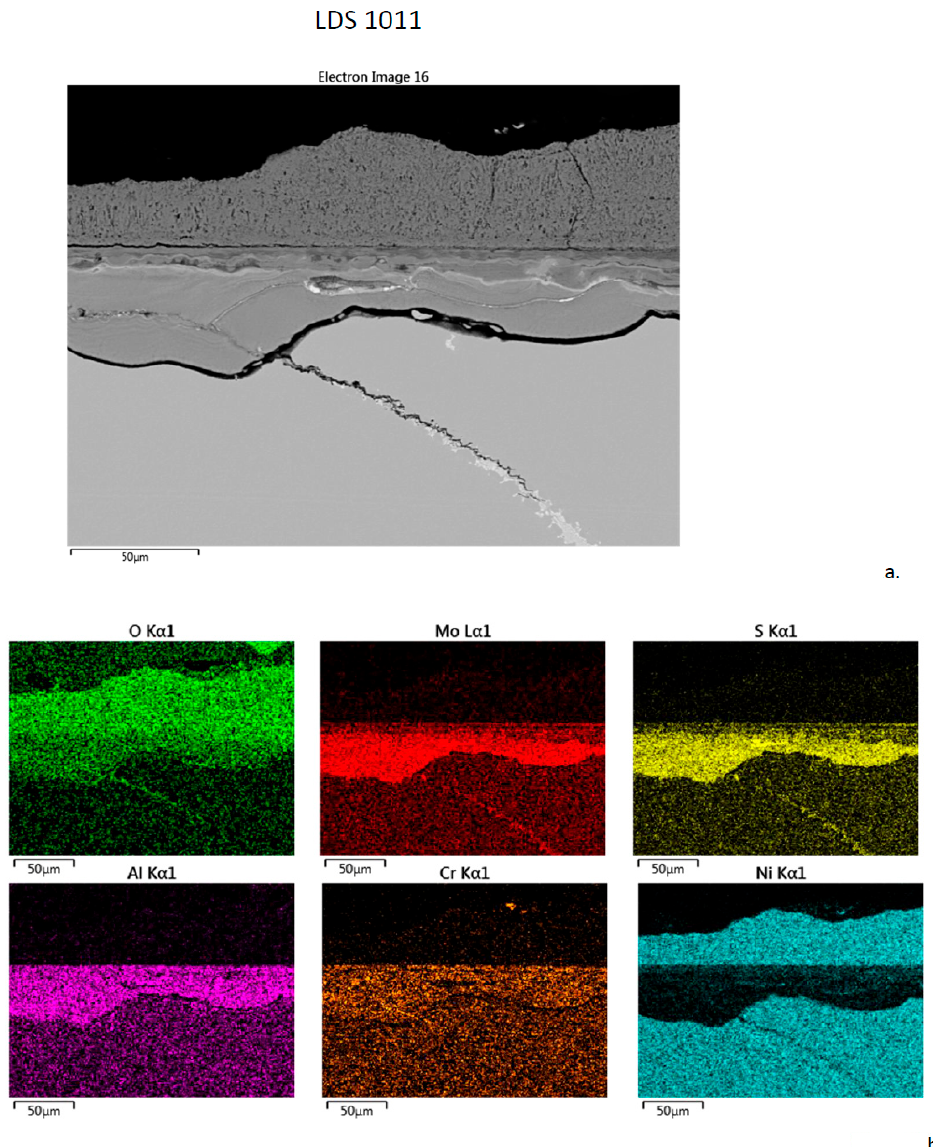
Figure 12. Cross-section of LDS 1011 sample after 300 h LTHC at 700 °C. ( a ) SE image showing thick distinct layers. ( b ) Elemental rasters for O, Mo, S, Al, Cr, Ni showing inner Al-Cr-S band and outer Ni-O band.